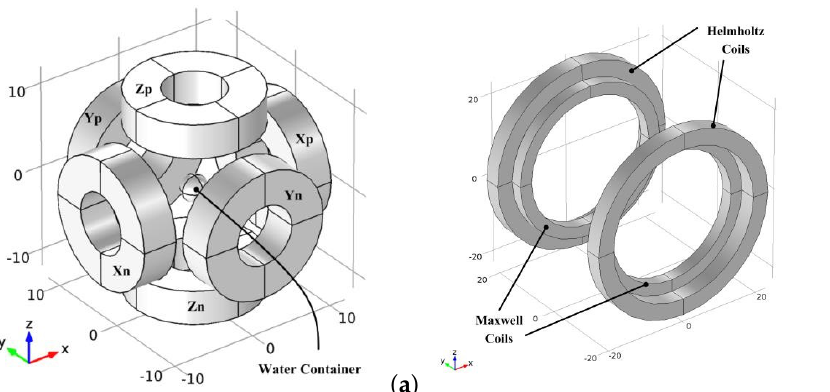
Figure 13. 3DMH EMA platform developed by Dadkhah et al. [74]: ( a ) representation of the concept; and ( b ) the design of a set of electromagnets for a given axis that combines a pair of Helmholtz and Maxwell